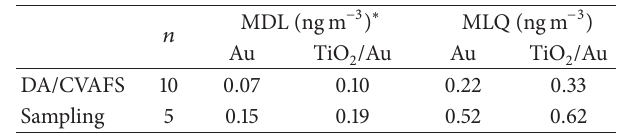
Table 3: Method analytical performances.